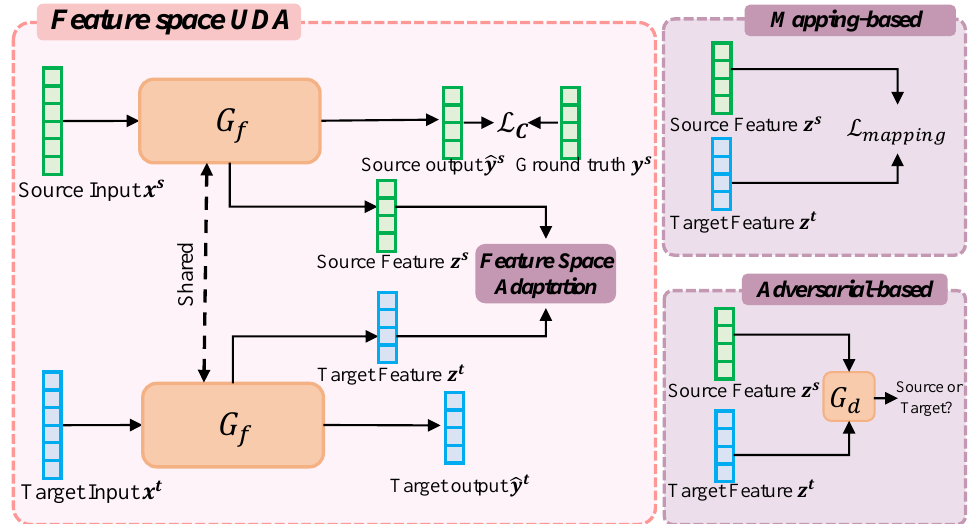
Figure 10. Diagram of feature space adaptation, including mapping-based ( top right ) and adversarial- based ( bottom right )